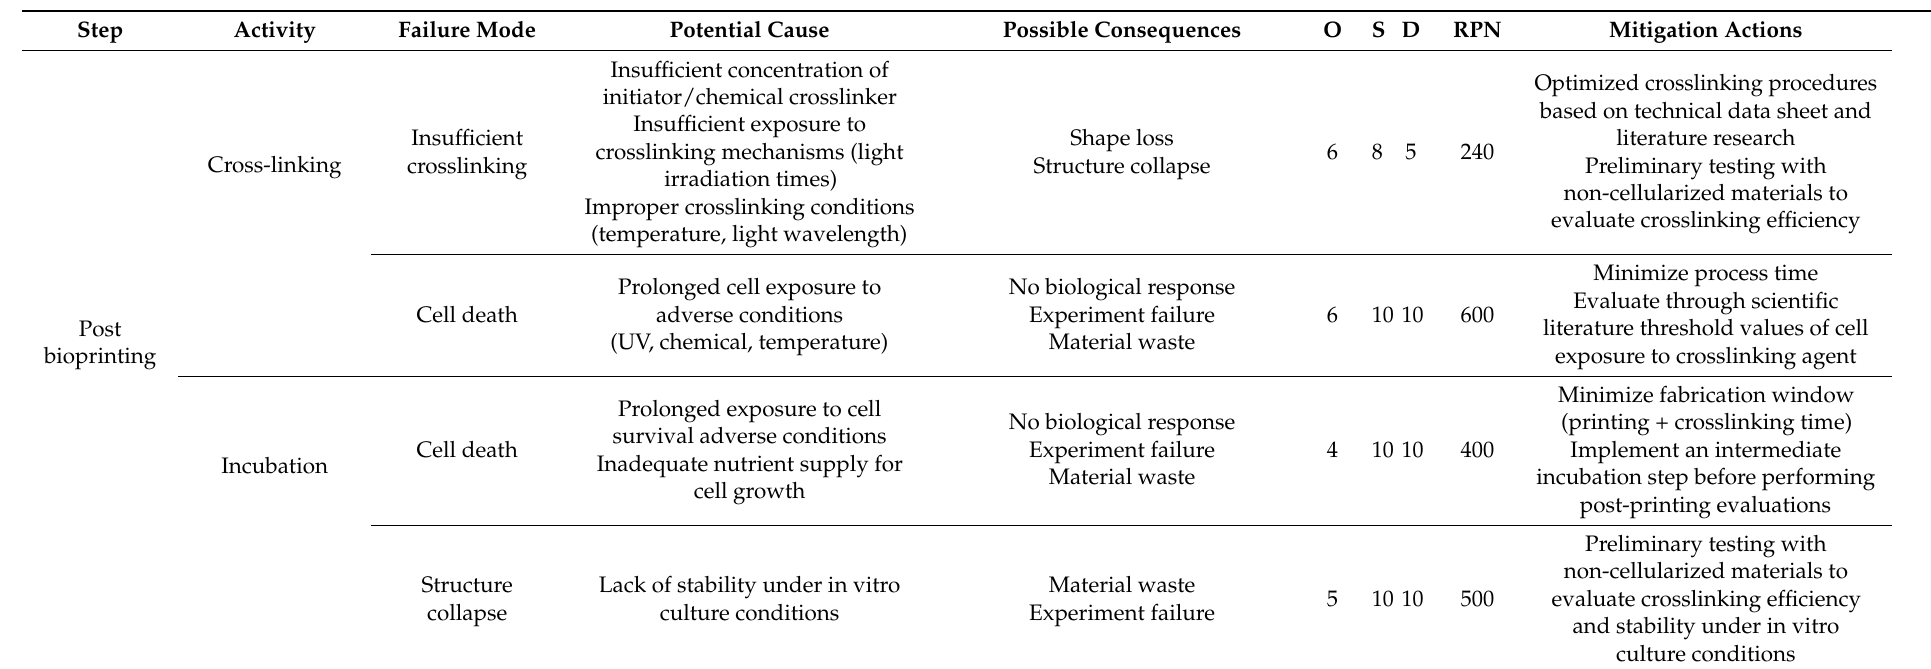
Table 7. FMEA/FMECA of the post-bioprinting